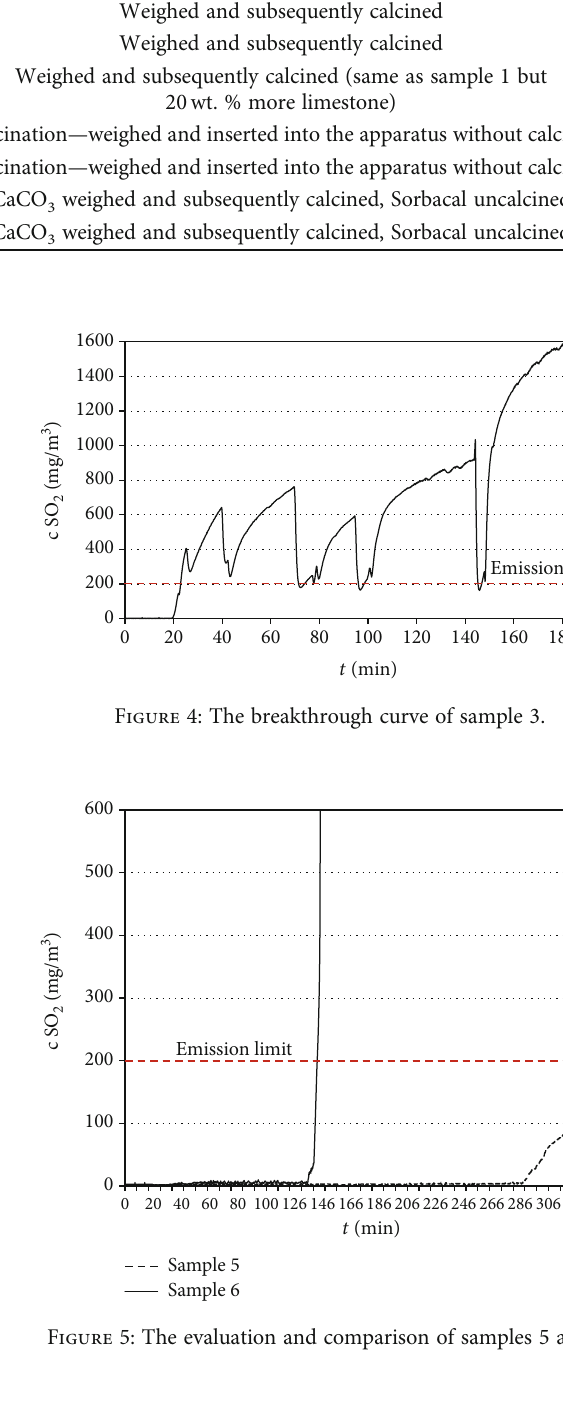
Figure 3: The breakthrough curve of sample 2.